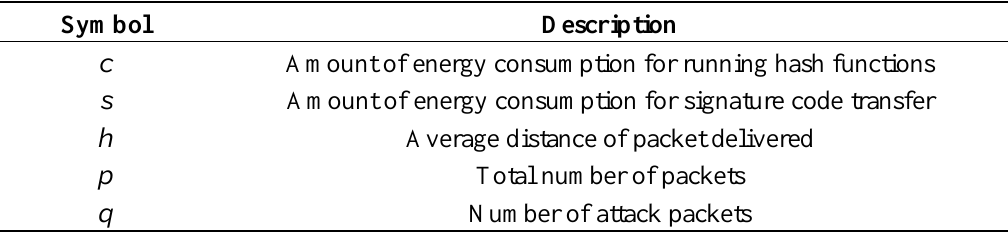
Table 1. Symbols used in energy consumption calculations.